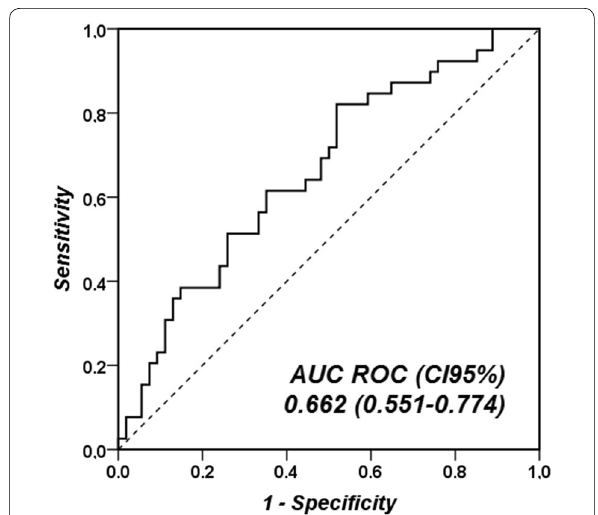
Fig. 3 Receiver operating characteristic (ROC) curve for T1 endocan concentrations to predict poor evolution